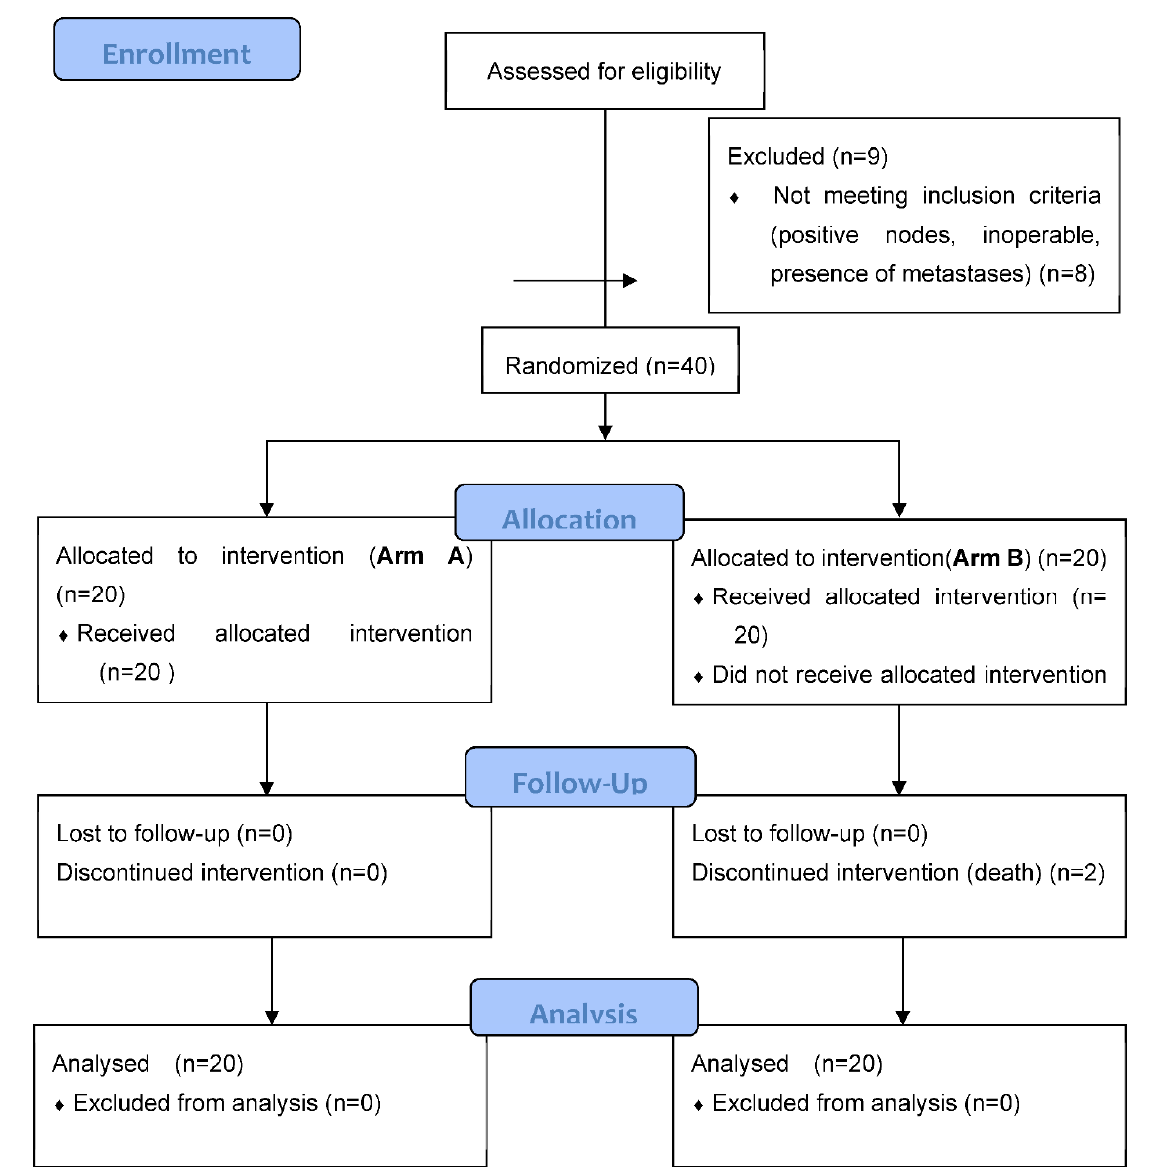
Figure 1. CONSORT Diagram. All patients proceeded with the treatment assigned at randomization. The acute treatment-related toxicities were similar (Table 2). Two patients in Arm B obtained a grade 3 proctitis (10%) which is lower than the Hebert trial [31]. At the time of this analysis, two patients had died in the Arm B group. One patient in the Arm B group was admitted during week 2 for acute congestive heart failure and despite intensive care, his condition was uncontrolled and he died in week 8. A second patient in the Arm B group was declared ncCR and died from an acute myocardial infarction (MI) while awaiting his salvage surgery. He was known for a previous MI and had diabetes. Both were qualified as cancer deaths. In the Arm A group, a patient had a persistent pelvis abscess and required numerous surgical interventions. In the Arm B group, two patients had grade 3 proctitis with symptomatic rectal ulcers; one patient required transfusion, and both received plasma argon therapy that healed after 5 and 6 months from treatment completion, with one of the patients requiring hyperbaric oxygen